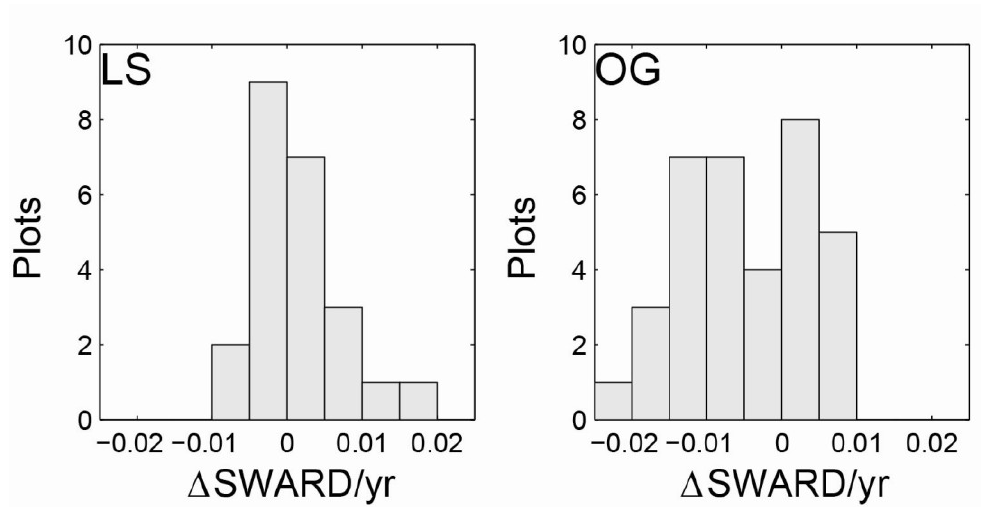
Figure 2. Histogram of annual changes in species-weighted additive relative density (SWARD; [48]) for the late-successional (LS) and old-growth (OG)